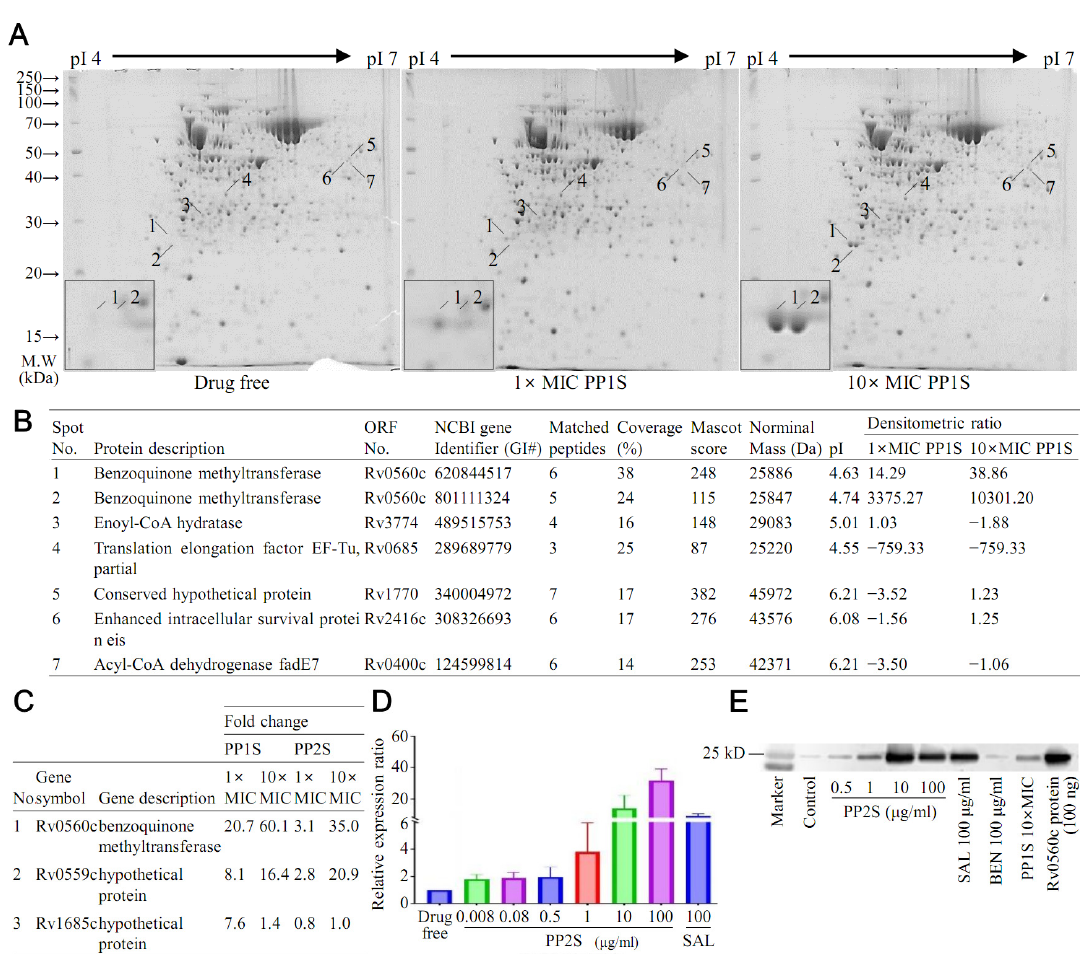
Figure 1. Gene expression changes in PPs-treated M. tuberculosis H37Rv. ( A ) Two-dimensional gel electrophoresis (2DE) analysis for protein expression in M. tuberculosis after treatment with 1× MIC and 10× MIC PP1S at 37 °C for 6 h. ( B ) Protein spots showing significantly different expressions between PP1S treated and untreated groups were identified. Two spots whose expressions were significantly increased by PP1S were found to be Rv0560c. ( C ) As a result of confirming the gene transcription pattern through microarray under the same conditions as 2DE, the most upregulated gene by PPs was Rv0560c. Overexpression of Rv0560c by PPs was confirmed by ( D ) RT-PCR and ( E ) Western blotting using an Rv0560c-specific antibody. ( D , E ) Rv0560c gene was also upregulated by salicylate (SAL). RT-PCR results are expressed as mean ± standard deviation.